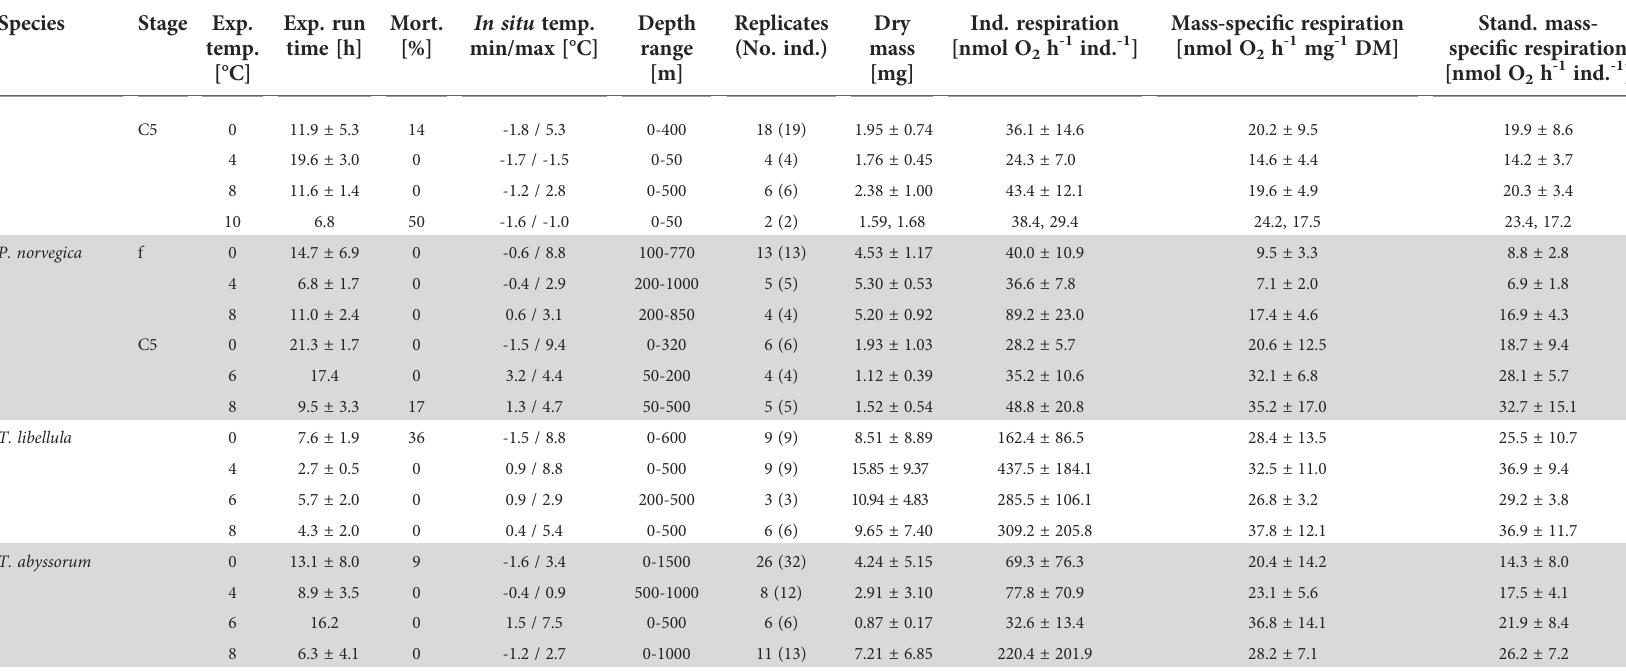
Data are given as mean values ± standard deviation. f, adult female; C5, copepodite stage C5; DM, dry mass; Exp. temp., Experimental temperature; Mort.,